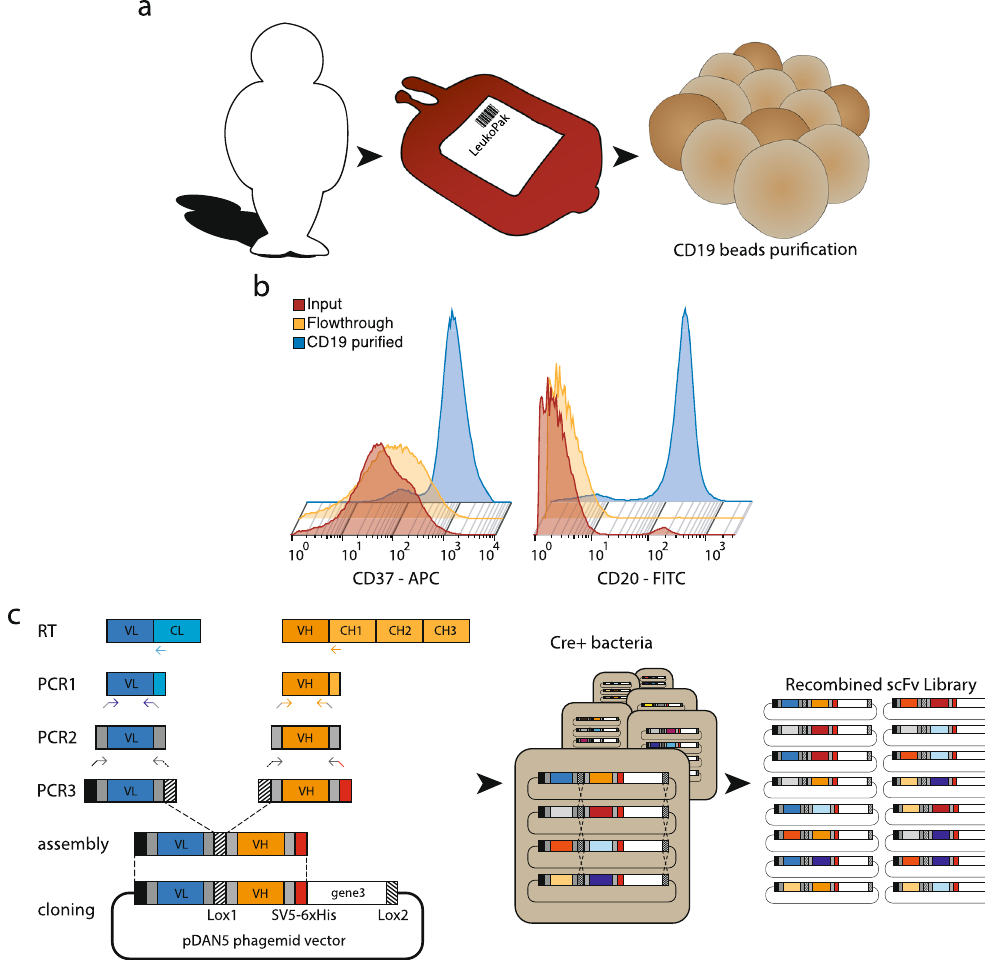
Fig. 1 Process fl ow for B-cell puri fi cation, V-region ampli fi cation, and cloning into pDAN5 phage display vector. a Schematics of B-cell puri fi cation of a single donor repertoire from LeukoPak. b FACS characterization of the CD19 + paramagnetically isolated cells for CD37 + (left) and CD20 + (right) staining. c Rescue of V domain diversity from donor and creation of the scFv phage antibody library: speci fi c constant domain primers are used for the RT-reaction, followed by V domain ampli fi cation with IGKV/IGLV and IGHV-speci fi c forward and reverse primers (PCR1). A second PCR introduces vector and linker overlaps (PCR2) that are exploited for the assembly of the scFv genes (PCR3). The genes are cloned into the pDAN5 phagemid vector by restriction enzyme digestion and transformed into bacteria. Upon superinfection with M13K07 helper phage, the phage is produced (primary library) and used to infect the recombinase positive bacteria (Cre + ) at a multiplicity of infection of 1:200. The presence of incompatible lox sites between IGKV/IGLV and IGHV domains and downstream g3p (in black and white) allows recombination to occur between different VH and VL genes carried by different phagemid vectors. The process yields a phage population (secondary library) that has greater recombinatorial diversity than the primary library. A fi nal phage production step, at a multiplicity of infection ≤ 1 restores the essential phenotype/genotype coupling (tertiary library/ fi nal